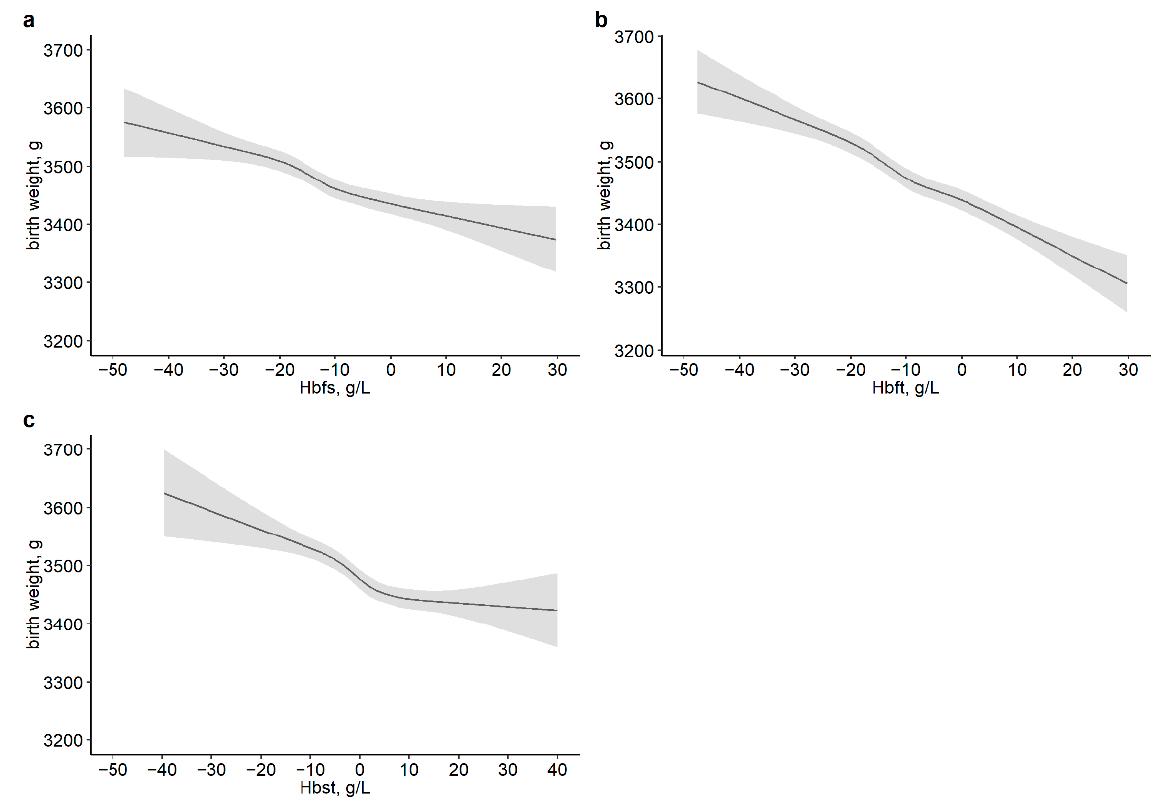
Figure 4. Dose–response associations of maternal hemoglobin change from first to late-second trimesters ( a ), from first to late-third trimesters ( b ) and from late-second to late-third trimesters ( c ) with neonatal birth weight. The p -values for overall associations were <0.001. The p -values for non-linear associations were 0.114 ( a ), 0.390 ( b ) and <0.001 ( c ). Models were adjusted for maternal age, education, parity, neonatal gender, gestational age at delivery, mode of delivery, maternal BMI in the first trimester, weight gain during pregnancy, and Hb concentration in the first trimester or in the late-second trimester. Hbfs, Hb in late-second minus Hb in first; Hbft, Hb in late-third minus Hb in first; Hbst, Hb in late-third minus Hb in late-second.